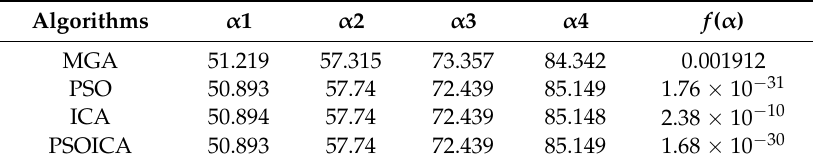
Table 4. Switching angles and costs at 0.2 modulation